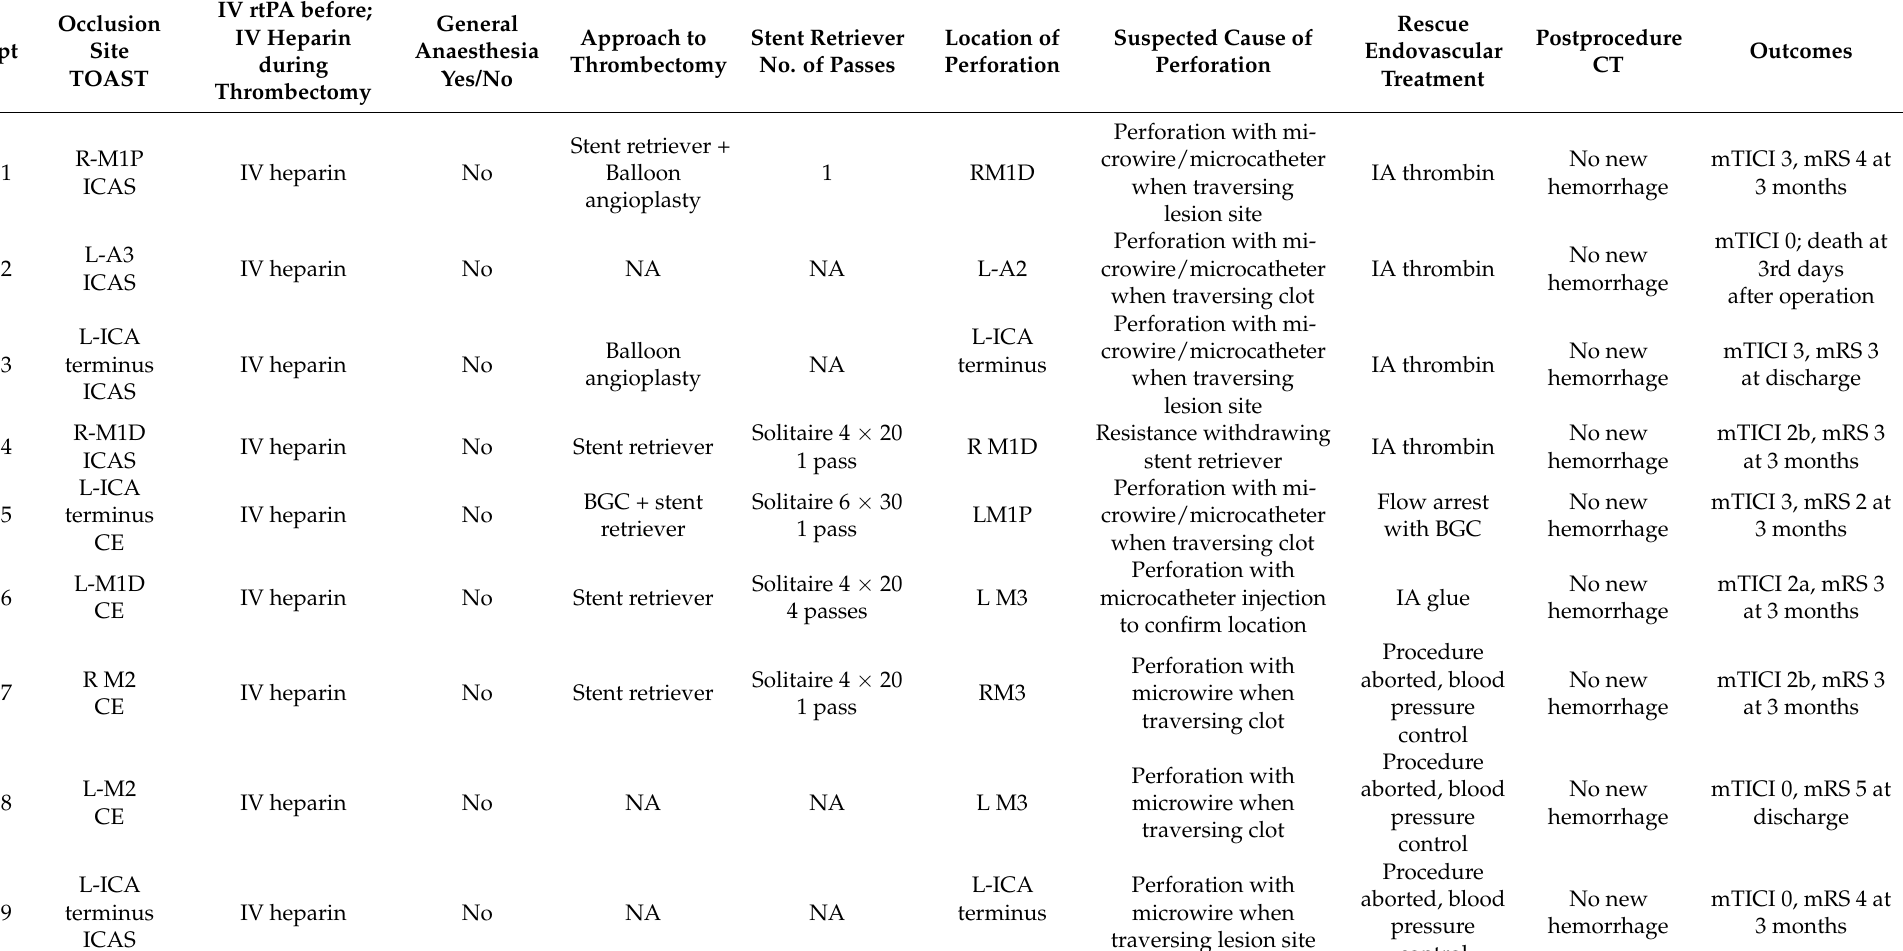
Table 1. Summary of technical details of thrombectomy, rescue approaches, and outcomes in patients with intraprocedural vessel